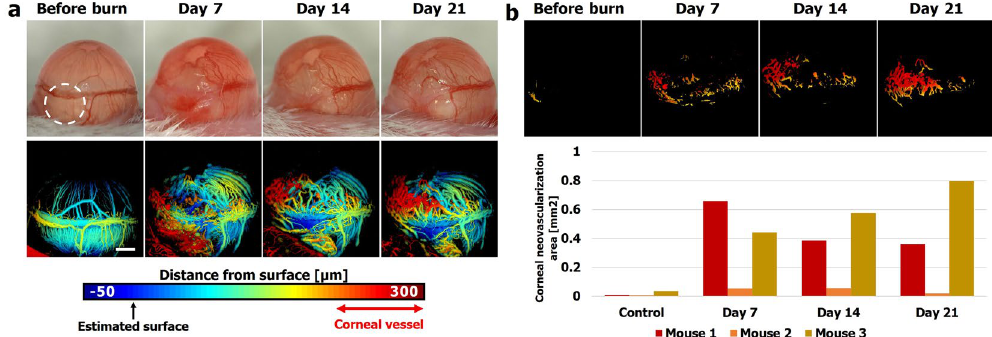
Figure 3. ( a ) Representative photographic images (upper row) and surface-based depth-encoded images (lower row) taken before alkali burn and 7, 14, and 21 days after alkali burn. The burned areas are highlighted with white dashed circles. ( b ) Images after supra-surface vessel isolation from the surface-based depth-encoded images (upper panel) and quantified corneal neovascularization area of the three mice after alkali burn (lower panel). Scale bar: 500 μ